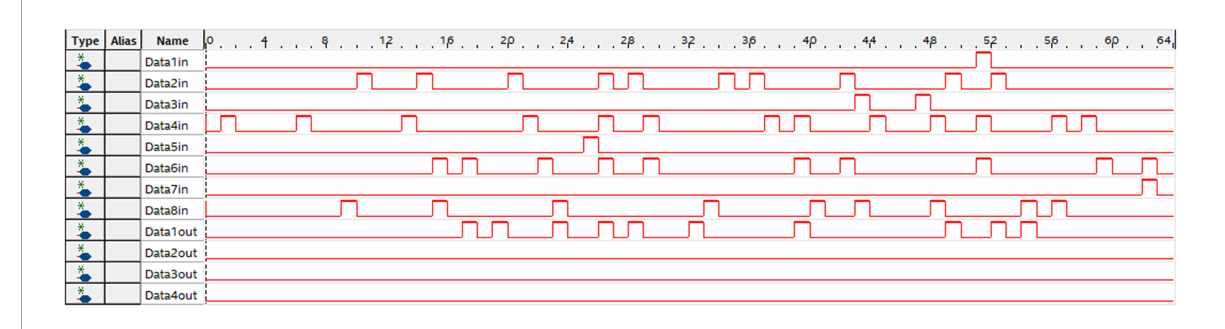
FIGURE7 An example of spike pattern inputs and outputs of spiking neural network (SNN) on the field-programmable gate array (FPGA). Spike trains with a certain frequency distribution are input to SNN for classification. The output port “Data1out” outputs the most spikes, reflecting the prediction label according to this spike pattern.